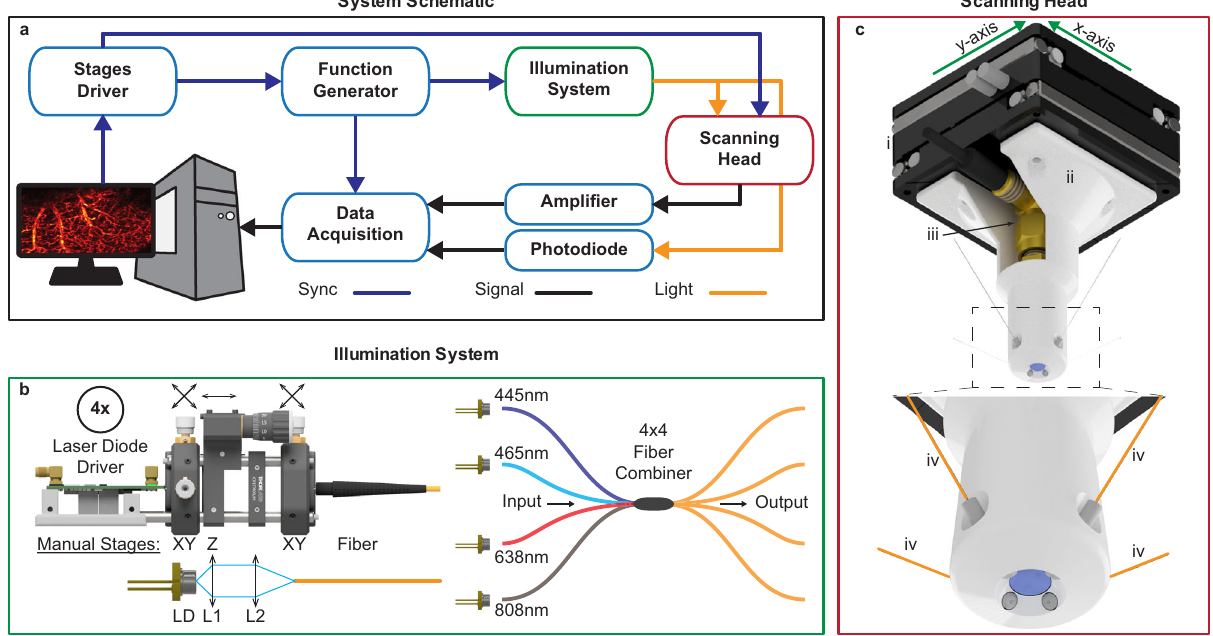
Fig. 5 | Multispectral Raster Scanning Optoacoustic Mesoscopy system using fourlaserdiodes.a The schematicofthesystemdeveloped showing theelectrical and optical connections of the different parts of the system. b The laser diode illumination system. Each laser diode is attached to a separate laser diode driver and focused into a multimode fi ber with a 2-lens system. The four laser diodes are coupledina4× 4 fi berpowercombinerandeachoutputof thecombinerhas~25% of the powerofeach input, combining allthe wavelengths. c The scanning head of